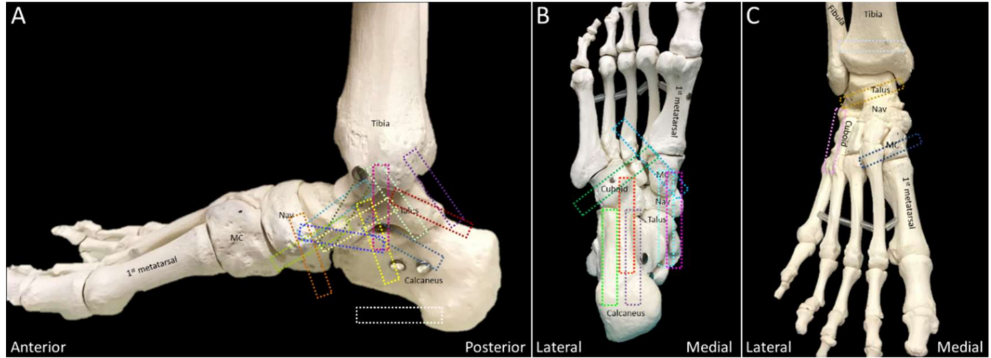
Figure 3. Colored dashed rectangles indicate the transducer positions on the medial ( A ), plantar ( B ), and anterior ( C ) aspects of the ankle and foot. MC: medial cuneiform; NAV: navicular.